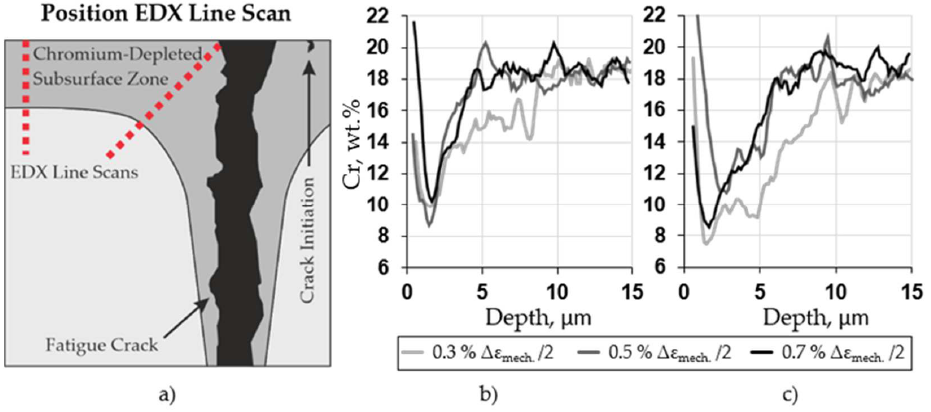
Figure 11. ( a ) Schematic illustration of the chromium-depleted zones and traces of the EDX line scans marked in red for scans from ( b ) the un-cracked surface to the center and ( c ) at the crack initaion site.